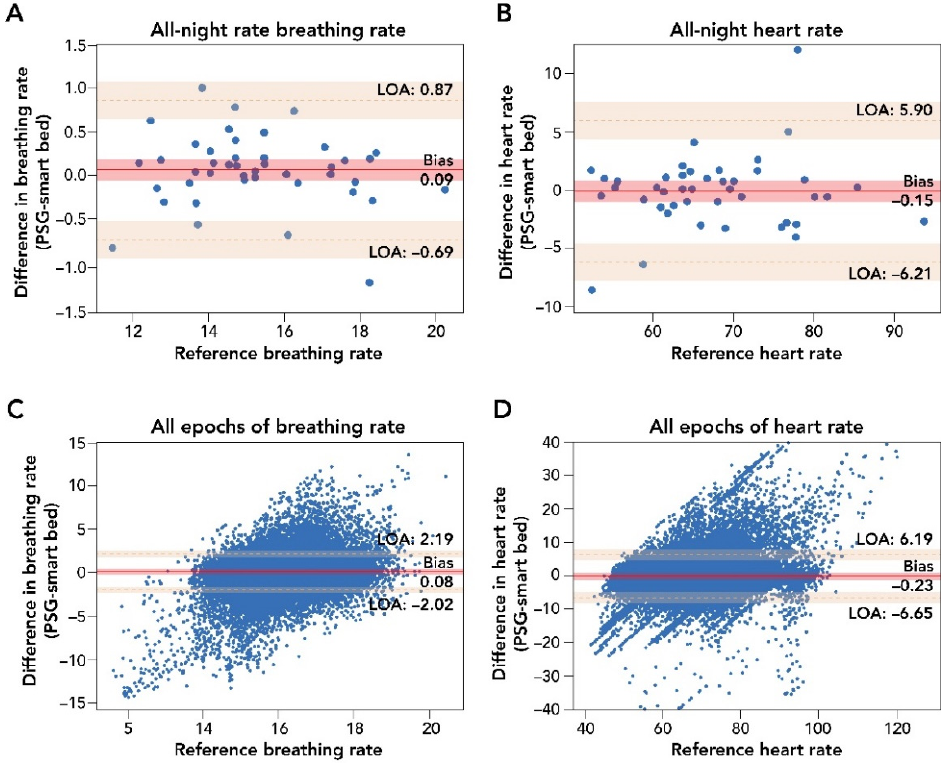
Figure 3. Bland–Altman comparison of all-night and epoch-by-epoch mean BR and HR measurements by smart bed versus PSG. Panels ( A , B ): Bland–Altman analysis of mean all-night measurements of BR and HR. The difference in biosignal measurement was plotted as a function of the reference PSG measurement. These analyses indicated a strong agreement of measurements (insignificant bias and narrow LOA) between the smart bed and PSG for both BR and HR. Panels ( C , D ): Bland–Altman comparison of epoch-by-epoch BR and HR from the smart bed and PSG. Epoch-by-epoch graphs plot the difference between simultaneously measured values for 30 s epochs from all 45 participants where there were measurements from both systems as a function of the reference (PSG) measurement. In this epoch-by-epoch analysis (minimum of 686 epochs to maximum of 1036 epochs per subject), calculations of bias and LOA were performed as previously described [38]. Epoch-by-epoch analysis indicated a strong agreement on instantaneous biosignals captured by smart bed and PSG. Solid and dotted red lines represent the bias and the upper and lower LOA; shaded areas represent the respective 95% confidence intervals. BR, breathing rate; HR, heart rate; LOA, level of agreement; PSG, polysomnography.